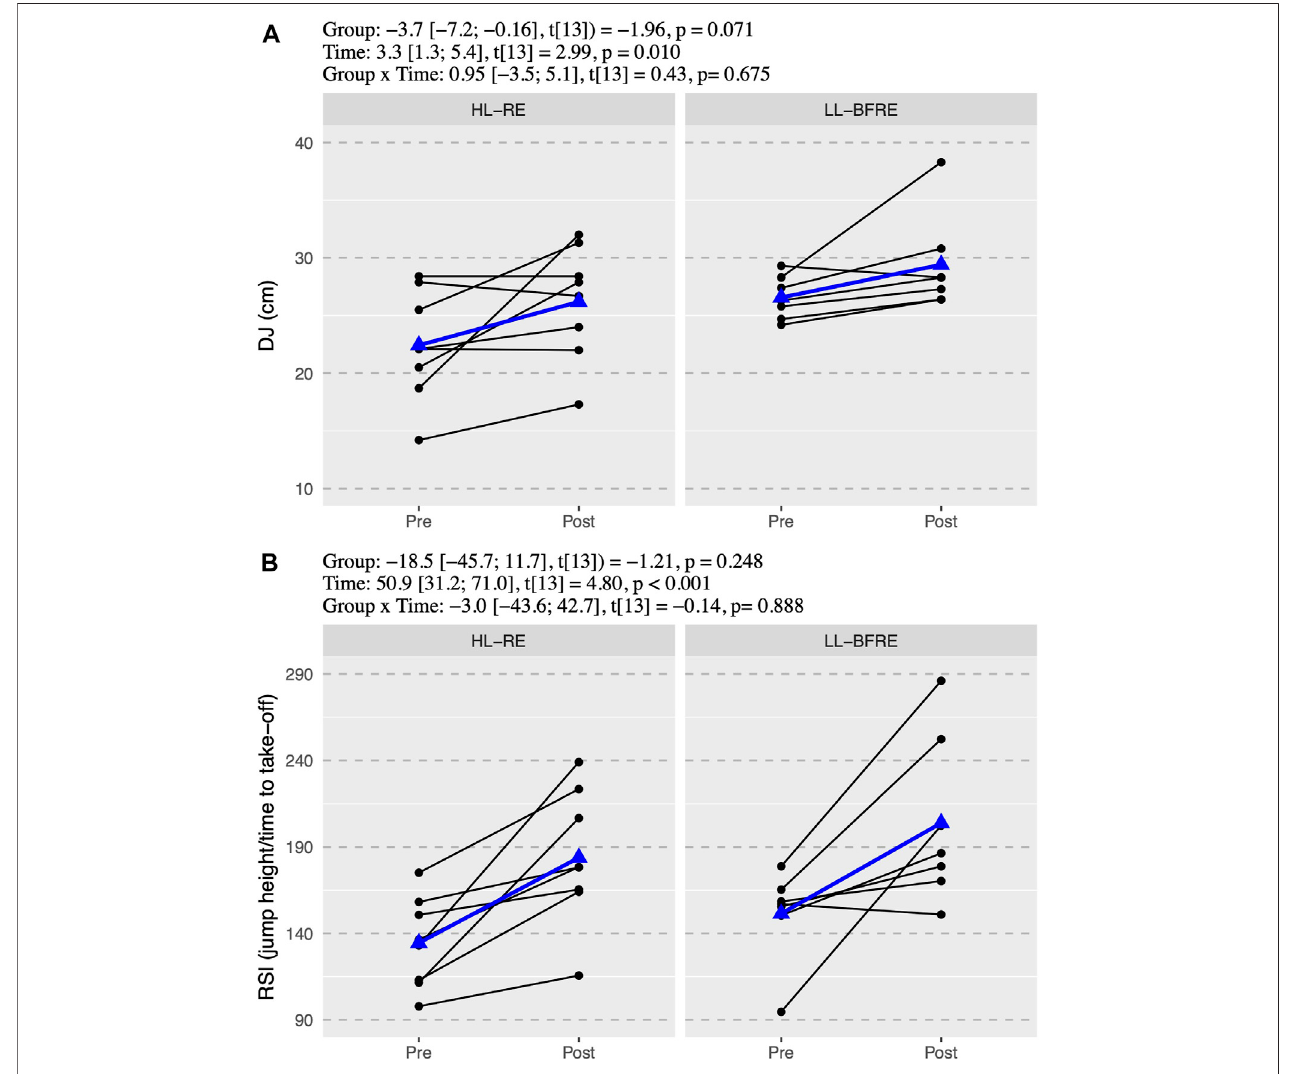
FIGURE 2 | The drop-jump values (A) and the reactive strength index (B) . Black points and lines represent individual responses. Blue triangles and regression line represent the mean response. Effects of the group (HL-RE vs. LL-BFRE), time (POST vs. PRE) and interaction (HL-RE vs. LLBFRE * POST vs. PRE) are presented through beta coef fi cient and 95% ofthe con fi dence interval, t-valueand p -value obtained after mixed model analysis. HL-RE: high-load exercises group; LL-BFRE: low- load blood fl ow restriction exercise group; DJ: drop-jump, RSI: reactive strength index calculated as jump height (cm) and ground contact time before take-off